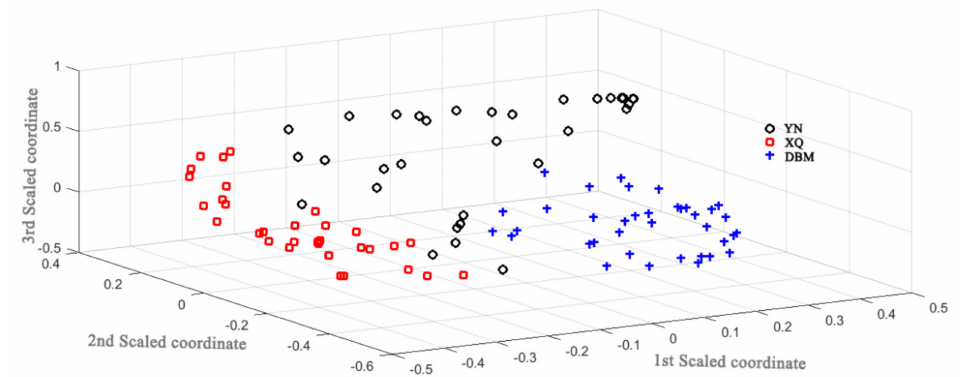
Figure 4. The NIR-based classification plot of PC for three main producing